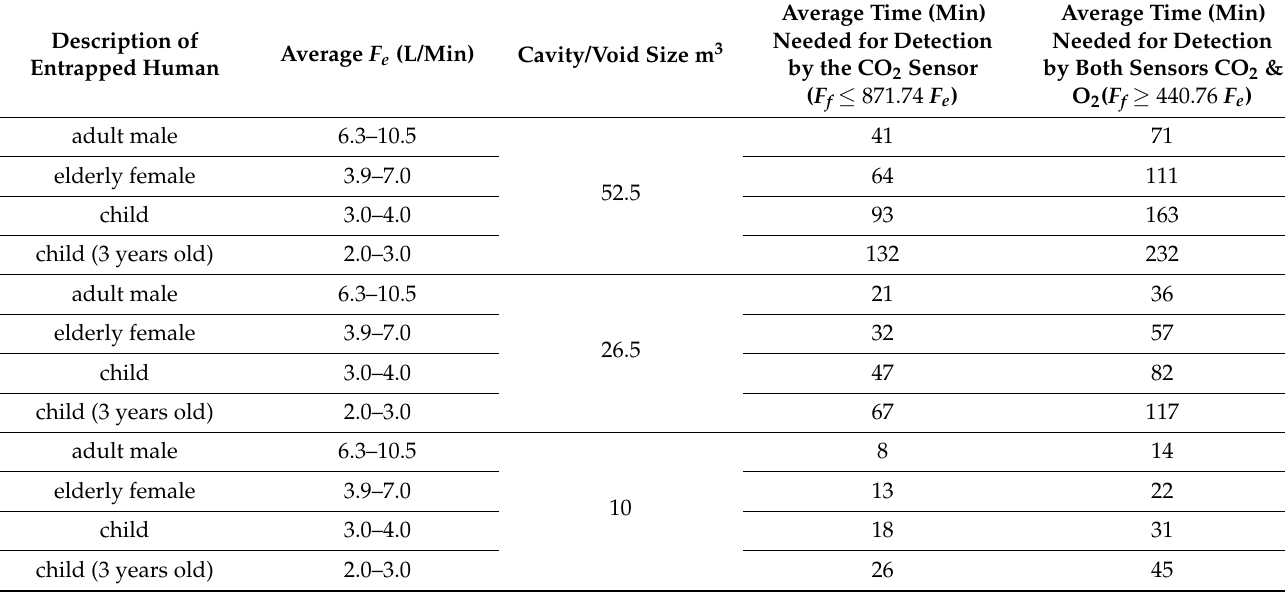
Table 4. Estimation of equilibrium